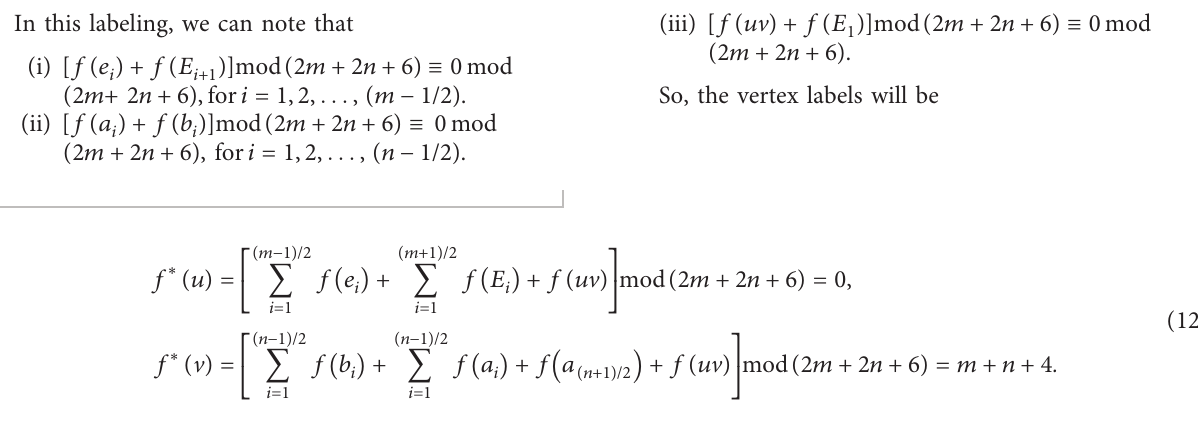
Figure 9: (a) B m and n are odd numbers. (b) B m,n when